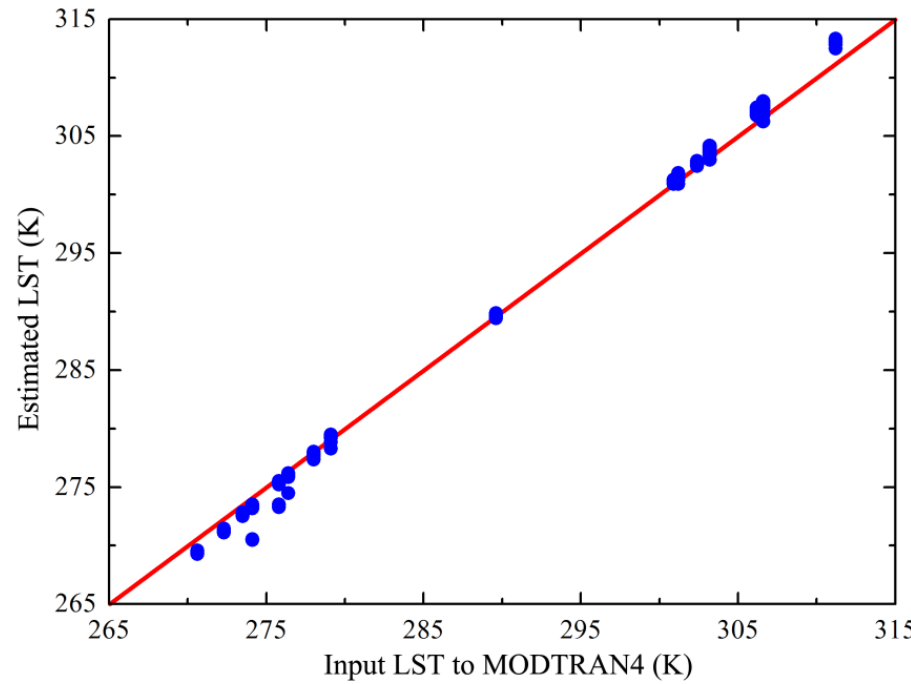
Figure 5. Scatter plot between the estimated LST and the LST input to the MODTRAN4 code for the eighteen radiosonde profiles. The solid line corresponds to a 1:1 relation.